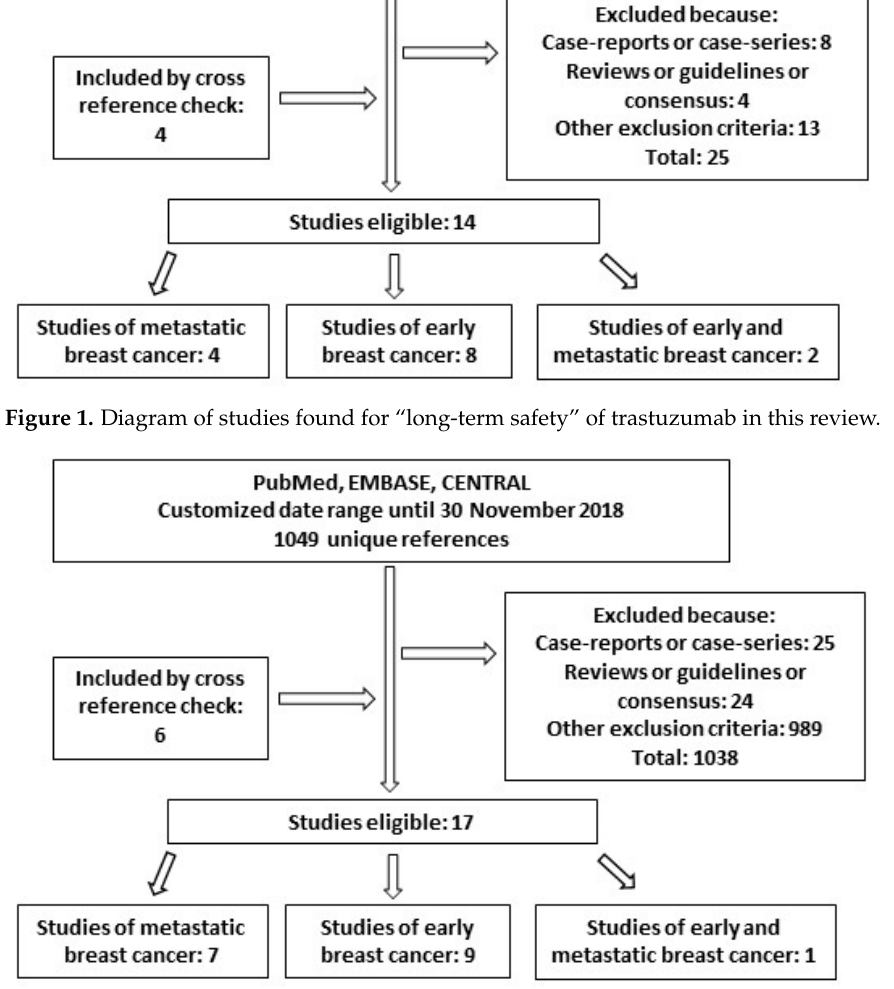
Figure 2. Diagram of studies found for “real-world effectiveness” of trastuzumab in this review.